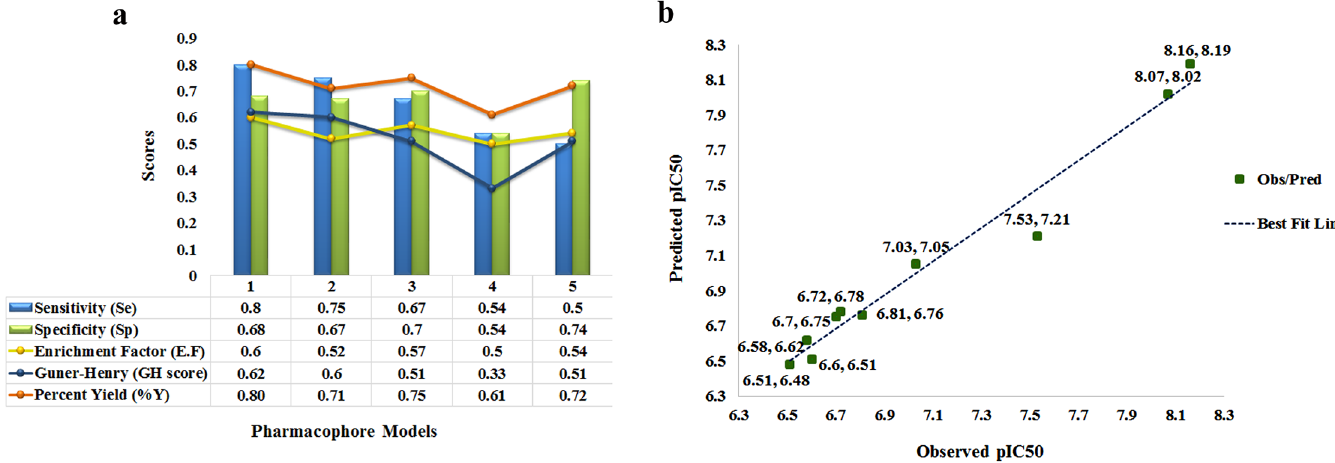
Fig 2. Statistical validation of designed pharmacophore and QSAR models. (a) Top five pharmacophore models labeled as Model (1 – 5). (b) Correlation analysis of QSAR regression model. Green dots depict the observed vs predicted IC 50 values and correlation best fit dotted line is shown in blue.